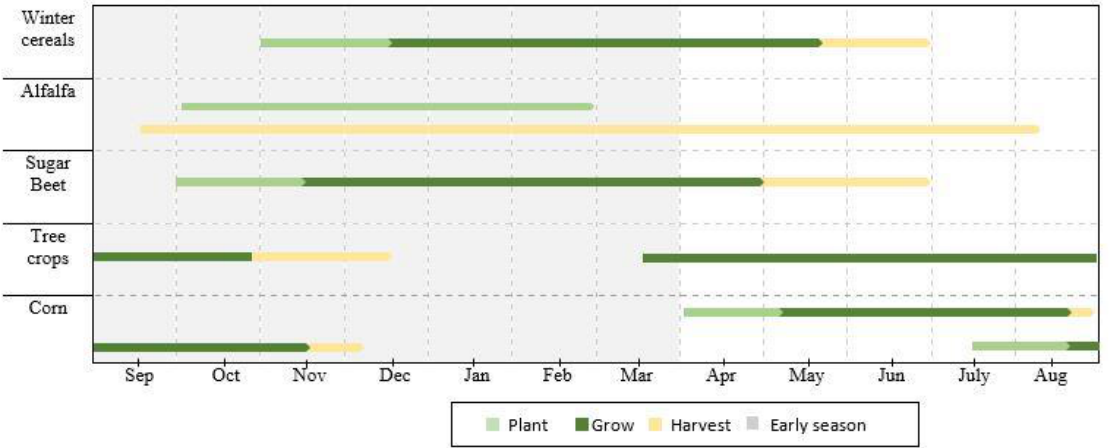
Figure 3. Calendar of planting, growing, and harvesting dates of the TIP crops for the growing season 2020/2021.